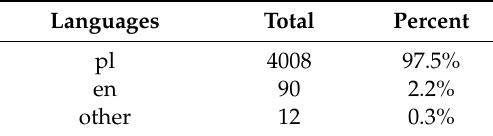
Table A42. English language availability (pl).